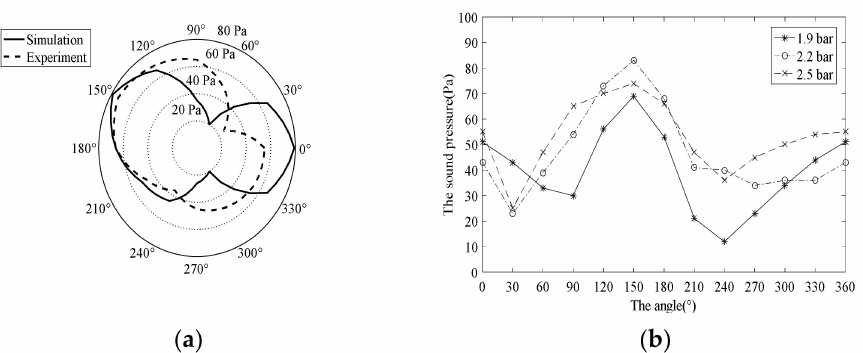
Figure 15. The acoustic pressure amplitude distributions: ( a ) For the inflation pressure of 2.5 bar; ( b ) For all these inflation pressures. Table 5. The RMS values between Figures 14b and 15b. The